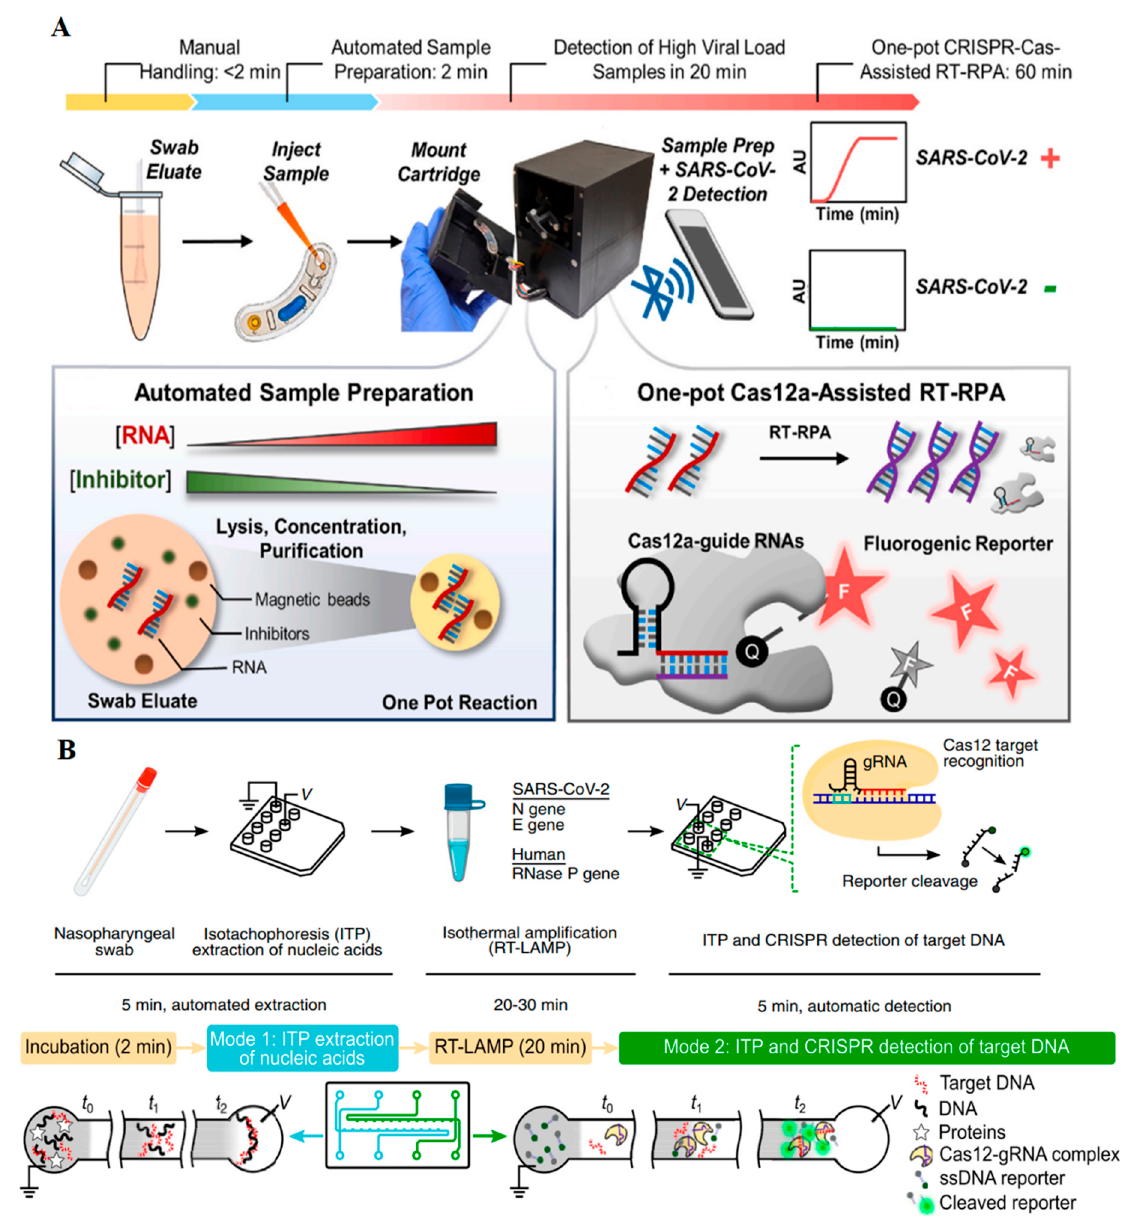
Figure 2. ( A ) POC-CRISPR assay with droplet microfluidics, in which RNAs are separated and concentrated using electrostatistical attachment to magnetic beads and fluorescent signals again using Cas12 trans cleavage [29]. ( B ) An electrokinetic microfluidic chip that creates isotachophoresis mobility in the microfluidic device for RNA separation and sensitivity enhancement [34]. Figures reprinted with permissions.